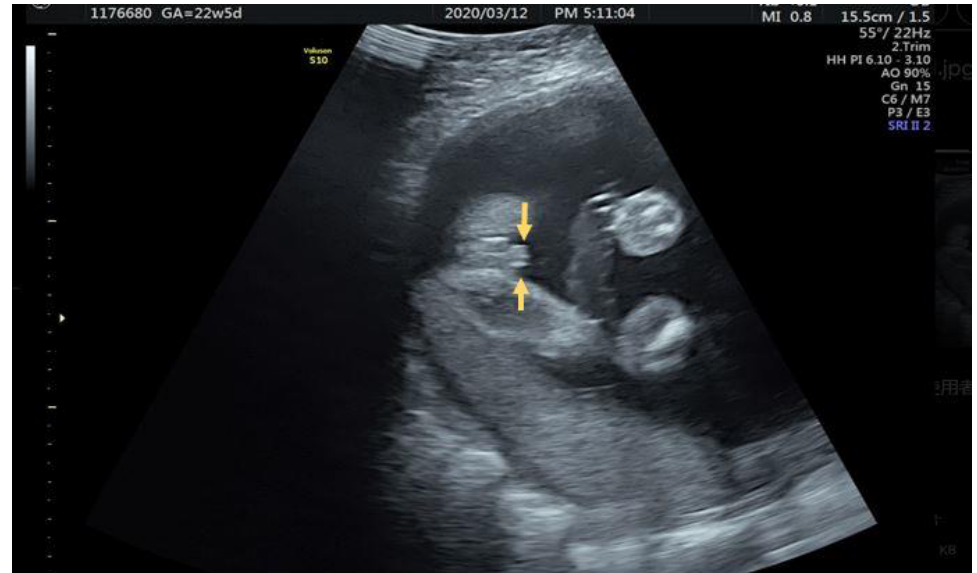
Figure 5. Parallel hyperechoic lateral prepuce fold alongside penis (arrow). der color Doppler confirming a third degree hypospadias. She visited another hospital and was lost in follow-up.